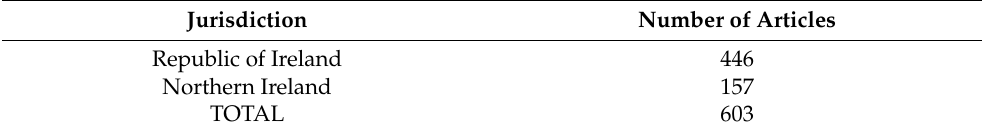
Table 2. Frequency of tweets from the Republic of Ireland and Northern